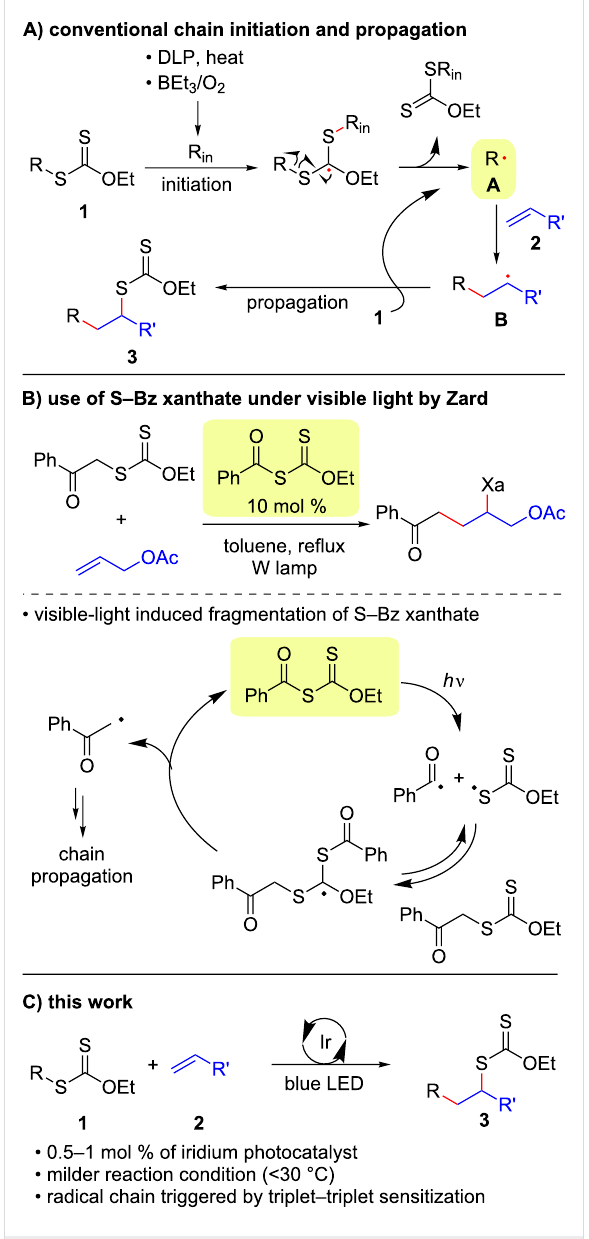
Scheme 1: Degenerative radical transfer of xanthates to